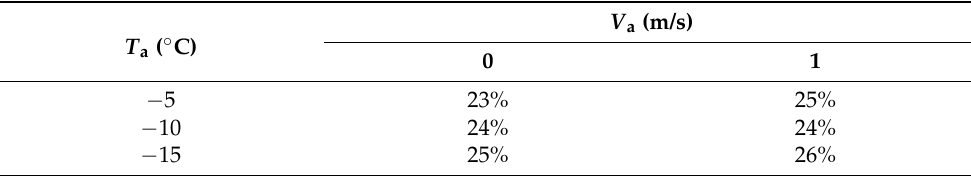
Figure 12. I t, foot of CG and WHI in different environmental conditions.